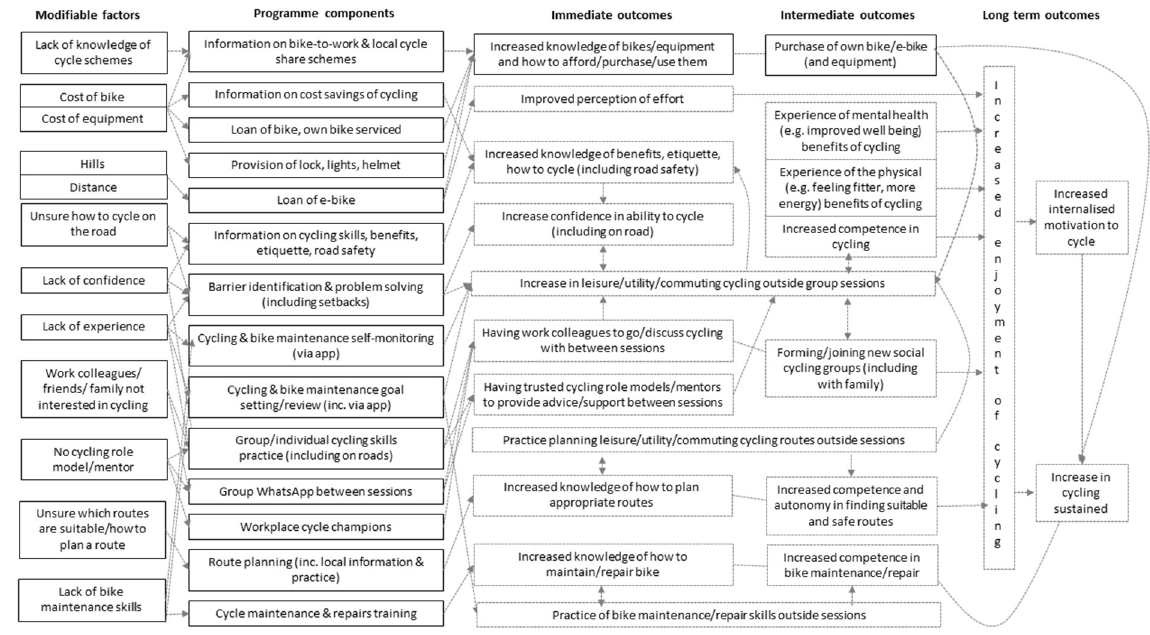
FIGURE2 The Cycle Nation Project program theory.